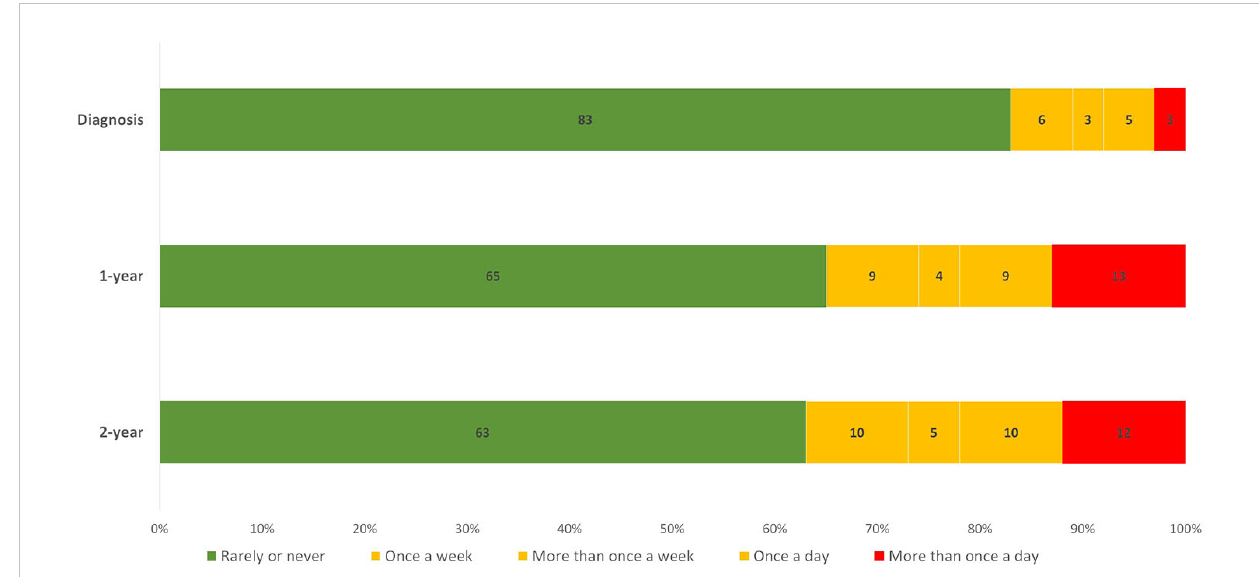
FIGURE 1 Distribution of the UI answers given by patients at diagnosis, 1-year and 2-year. The numbers displayed inside each bar are the percentages of the total number of patients for each individual time point. Green, yellow, and red bars represent patients with the least, moderate, and most severe forms of UI problems, respectively.